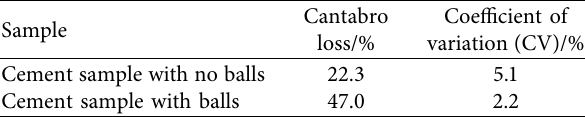
Figure 5: Cementitious samples with and without balls. (a) Top view. (b) Side view. Table 4: Cantabro losses of cement